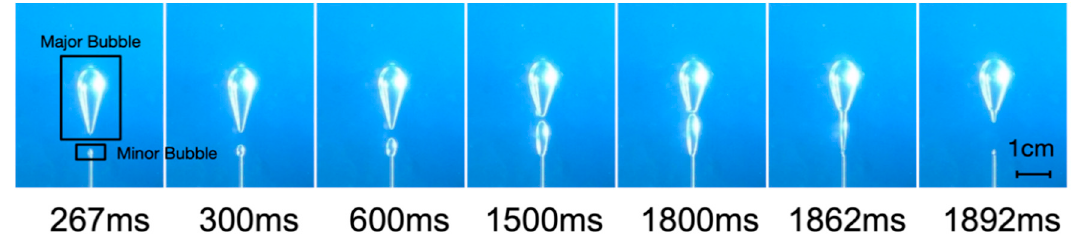
Figure 7. The minor bubble growth process.